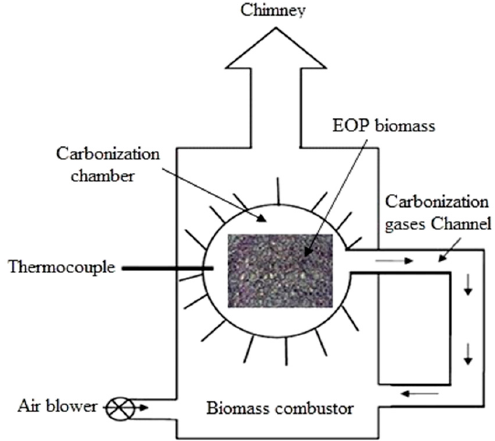
Figure 1. Schematic diagram of the EOP biomass carbonization plant.